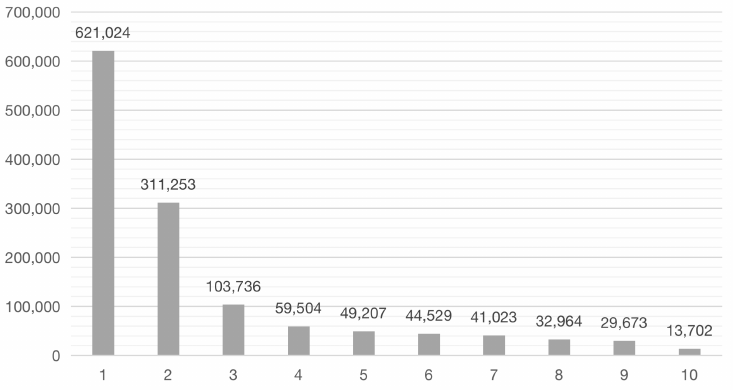
Figure 5. CodeHunter distribution of correct result